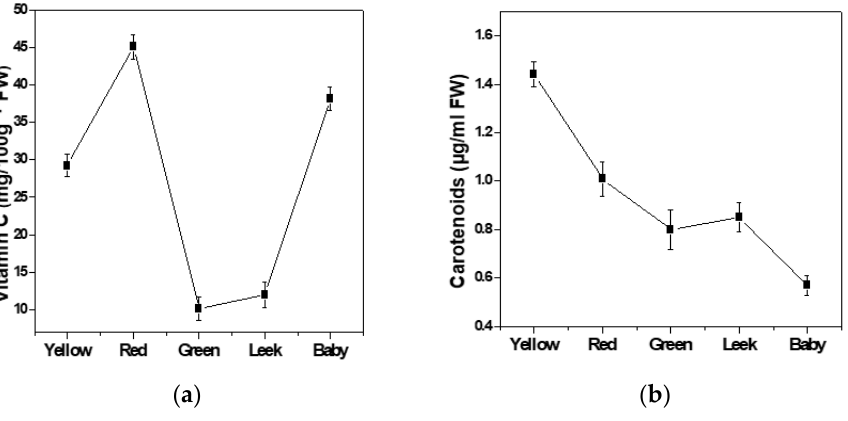
Figure 2. Vitamin C ( a ) and carotenoid values ( b ).